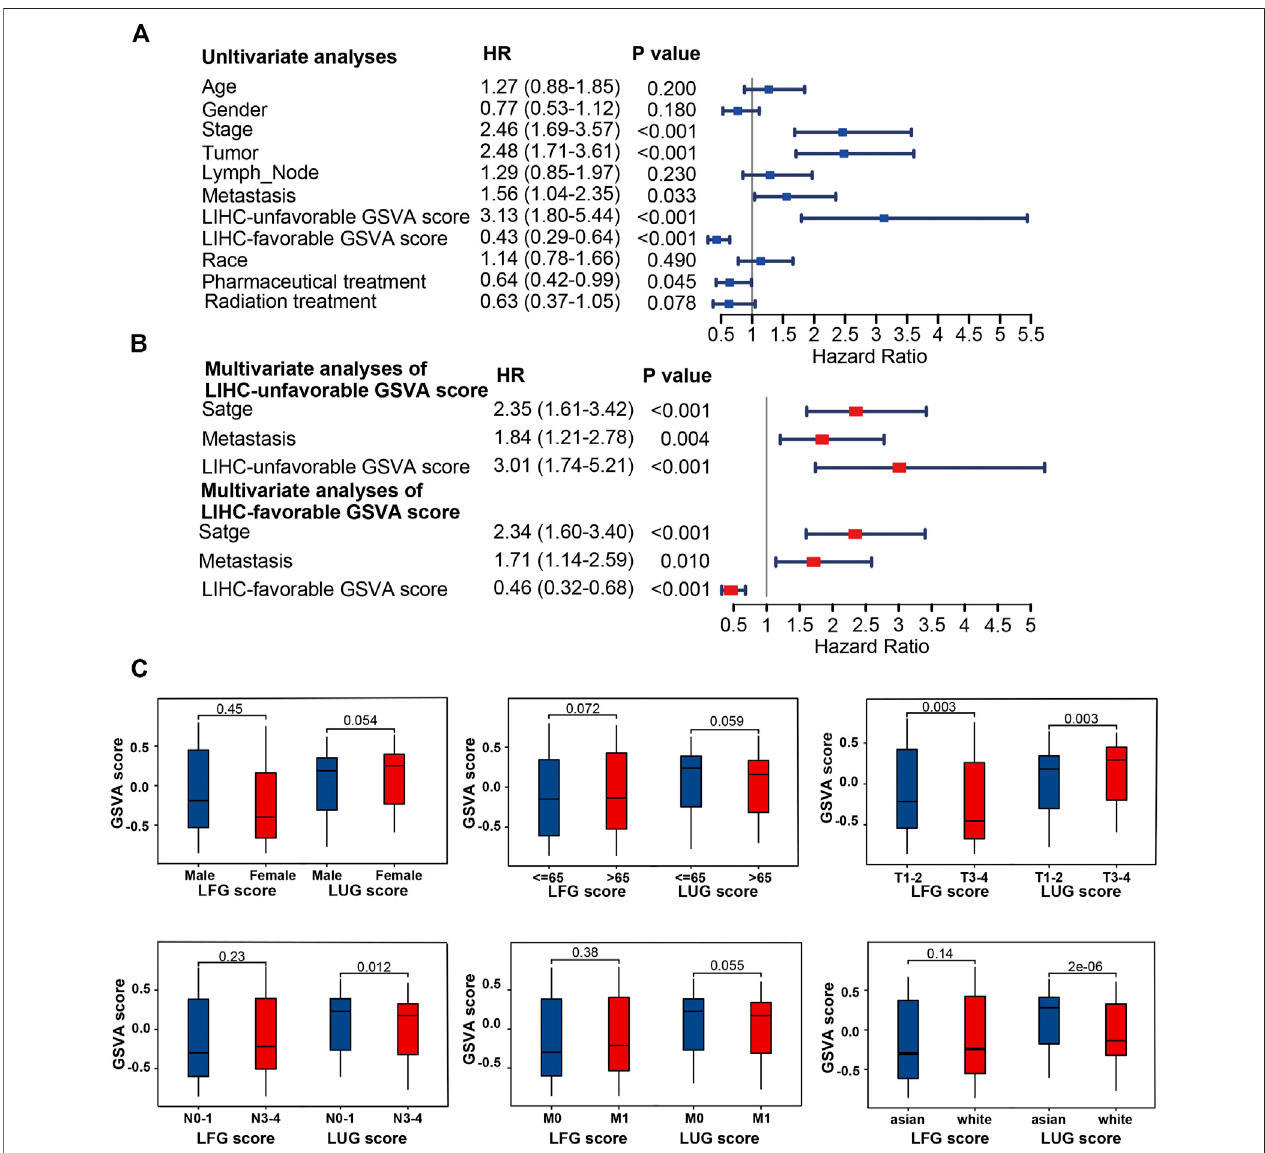
FIGURE 5 | Clinical correlation analyses and of LUG score and LFG score. (A,B) Univariate and multivariate Cox regression analysis. (C) Correlation of LUG score and LFG score with clinical features.